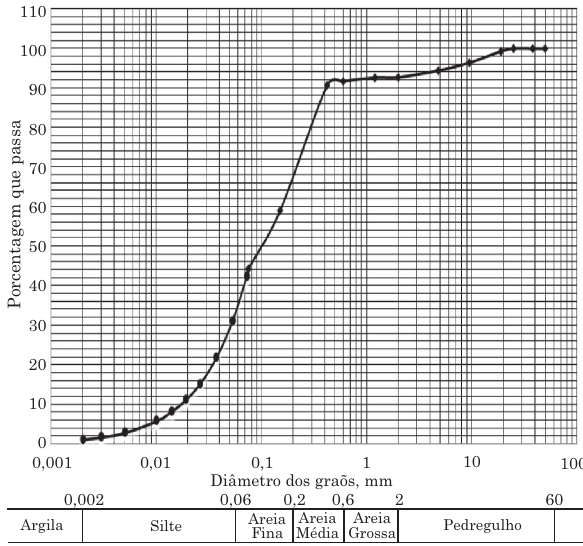
Figura 1. Resultado da granulometria